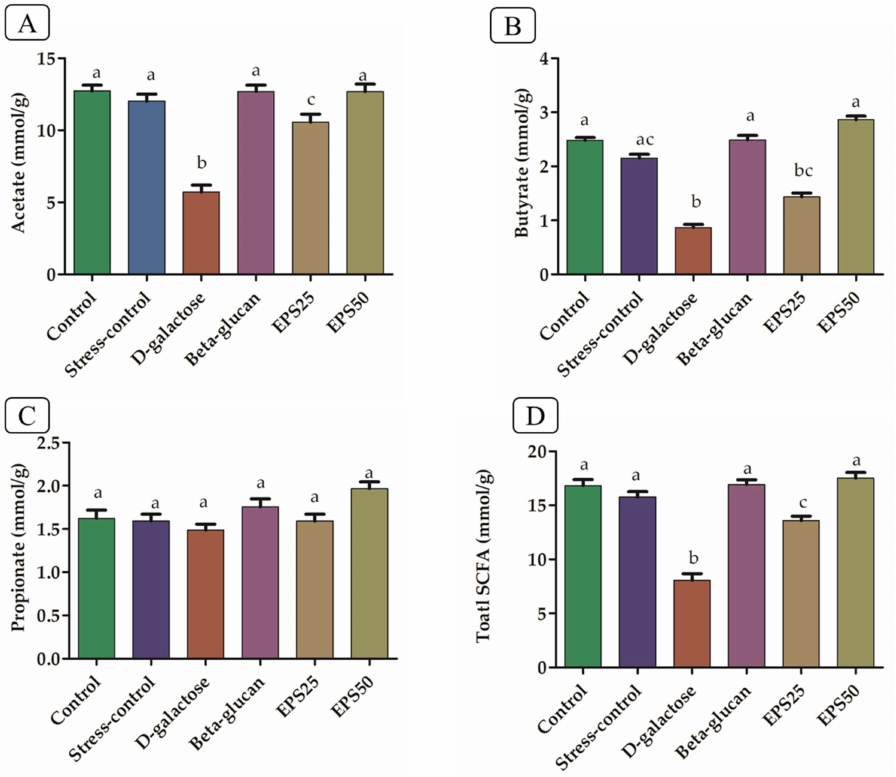
Figure 6. Short-chain fatty acid content in cecal samples of mice. ( A ) Acetate, ( B ) Butyrate, ( C ) Propionate, and ( D ) Total short-chain fatty acids (SCFA). Values are means ± SEMs. Data were presented as mean ± SEM. Data were analyzed using One-way ANOVA with Bonferroni post-test. Values with dissimilar superscript alphabets (a–c) indicate significant differences ( p < 0.05) among the treatment